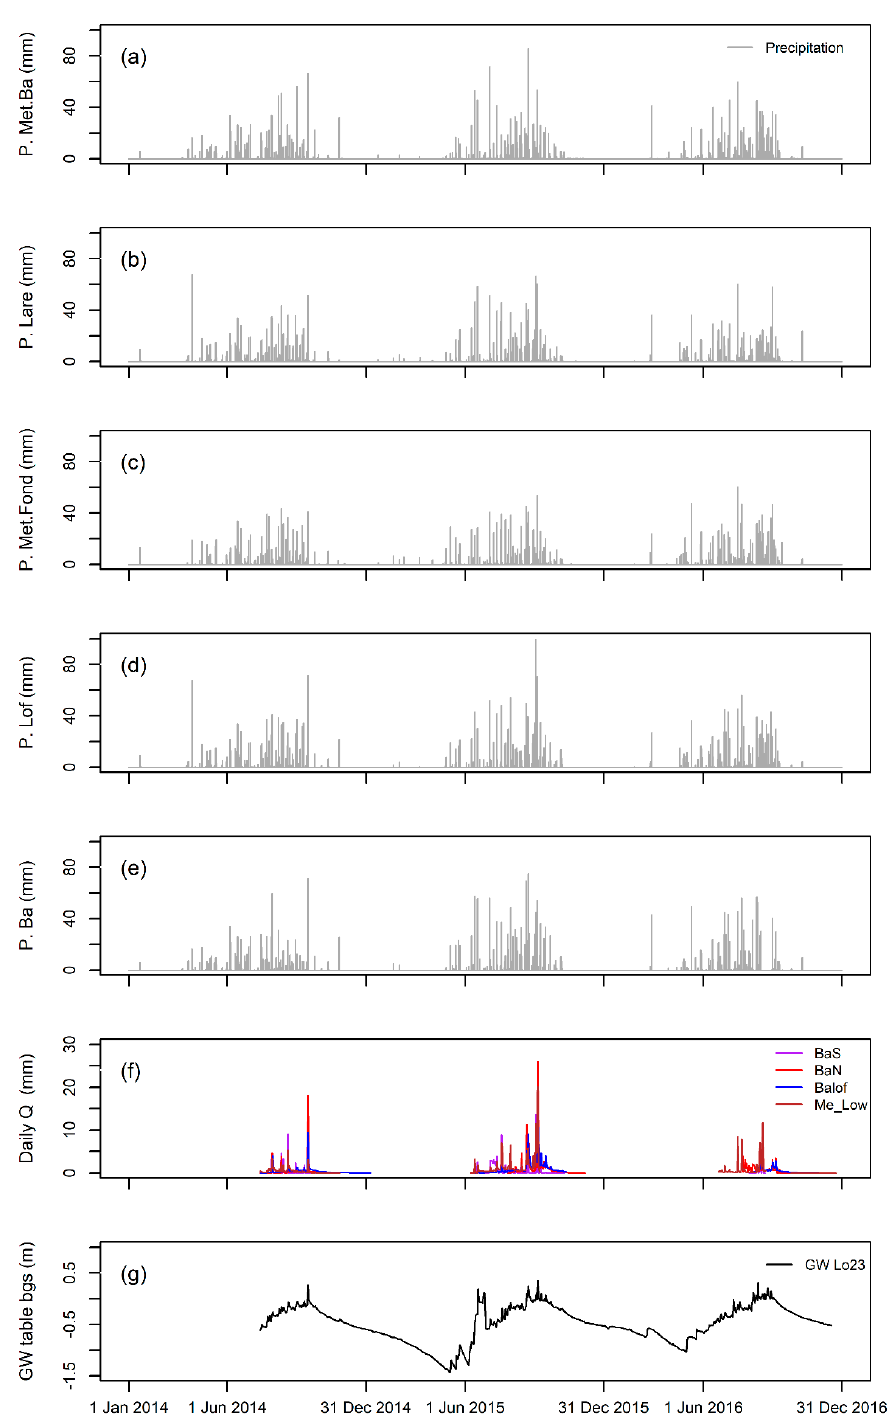
Figure 4. Daily observed ( a )–( e ) of precipitation (P), ( f ) discharge (Q), and ( g ) groundwater (GW) table below the ground surface (bgs) at different stations in the Mebar and Bankandi ‐ Loffing catchments from 2014 to 2016 (see Figure 1 for the location of each station; BaS: Bankandi ‐ south, BaN: Bankandi ‐ north, BaLof: outlet of Bankandi ‐ Loffing; Me ‐ low: outlet of Mebar).